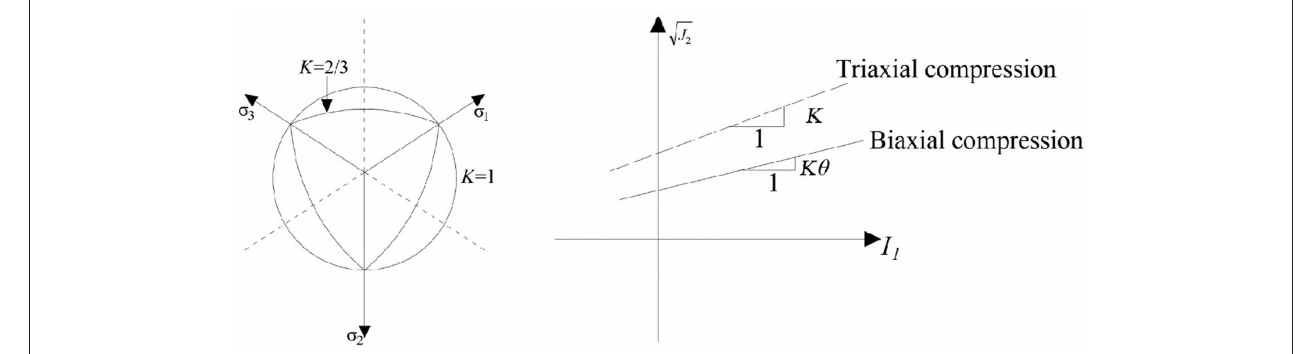
FIGURE 2 | Failure surface of the CDP Model.